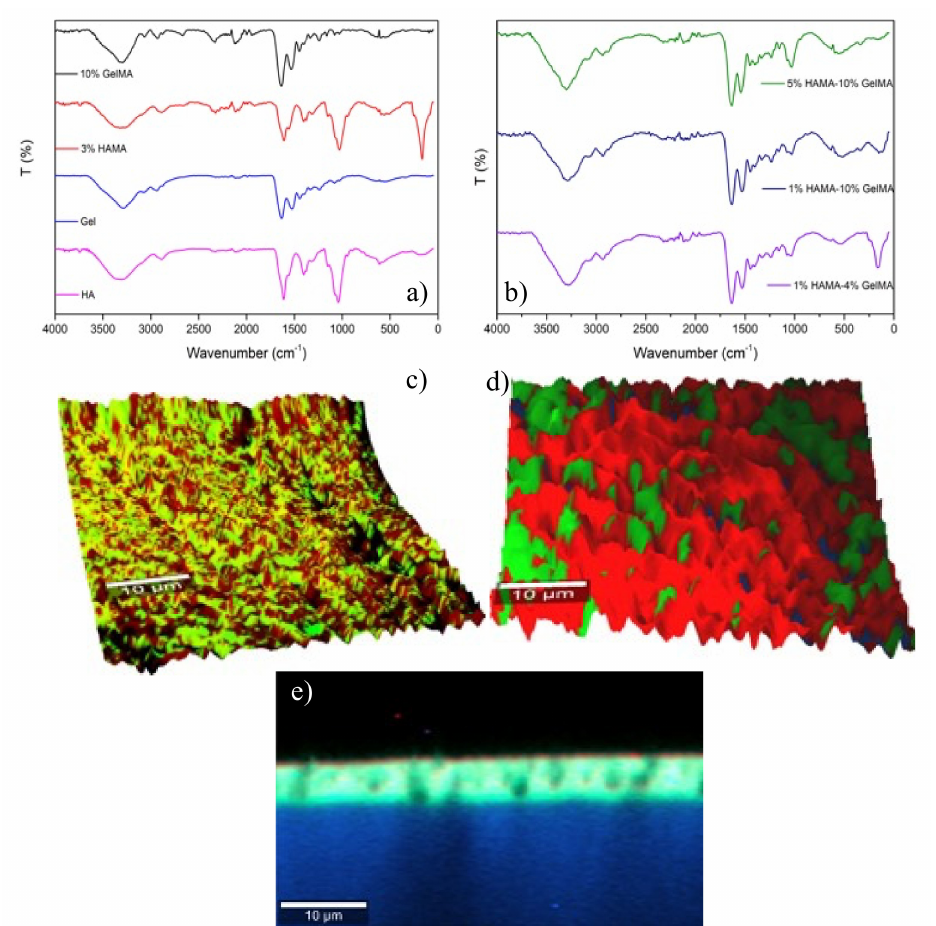
Figure 2. ( a , b ) FTIR spectra of selected pure HAMA, GelMA, and hybrid GelMA/HAMA hydrogels at different compositions. Surface topographical composition acquired by Raman confocal 3D imaging of ( c ) 2% GelMA (green)-1% HAMA (red) and ( d ) 5% GelMA (red)-1% HAMA (green) hybrid hydrogels. HAMA was detected using bands at ca. 1380 and 1410 cm − 1 , whereas GelMA was detected using a band of ca. 1455 cm − 1 . ( e ) In-depth Raman imaging of the 2% GelMA-1% HAMA hydrogel. The bright blue-greenish color on the hydrogel in depth denotes the perfect mixing of HAMA (green) and GelMA